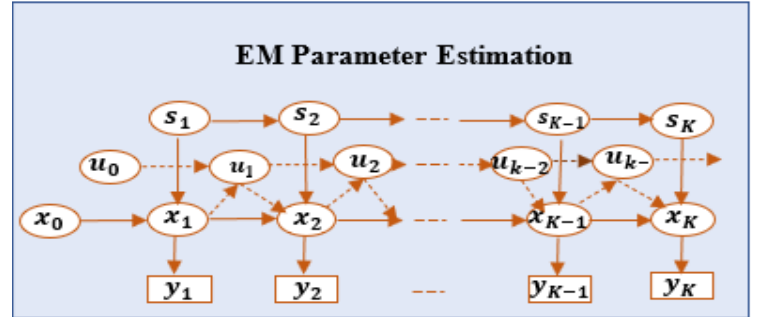
Figure 2. Dynamic Bayesian representation of JMLS composed of three variables and related deterioration variables over adjacent timesteps 𝐾 .